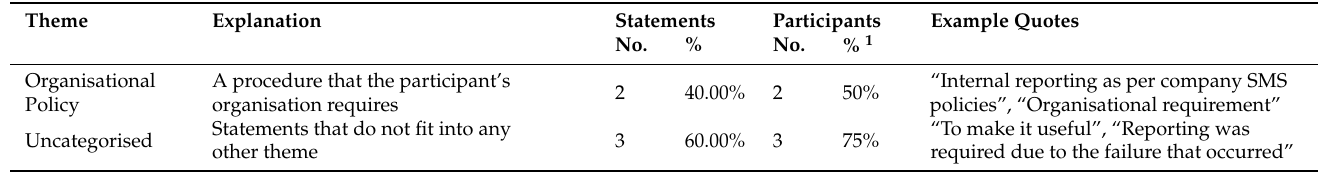
Table 6. Reasons for using both a CA005RPAS form and an internal process.